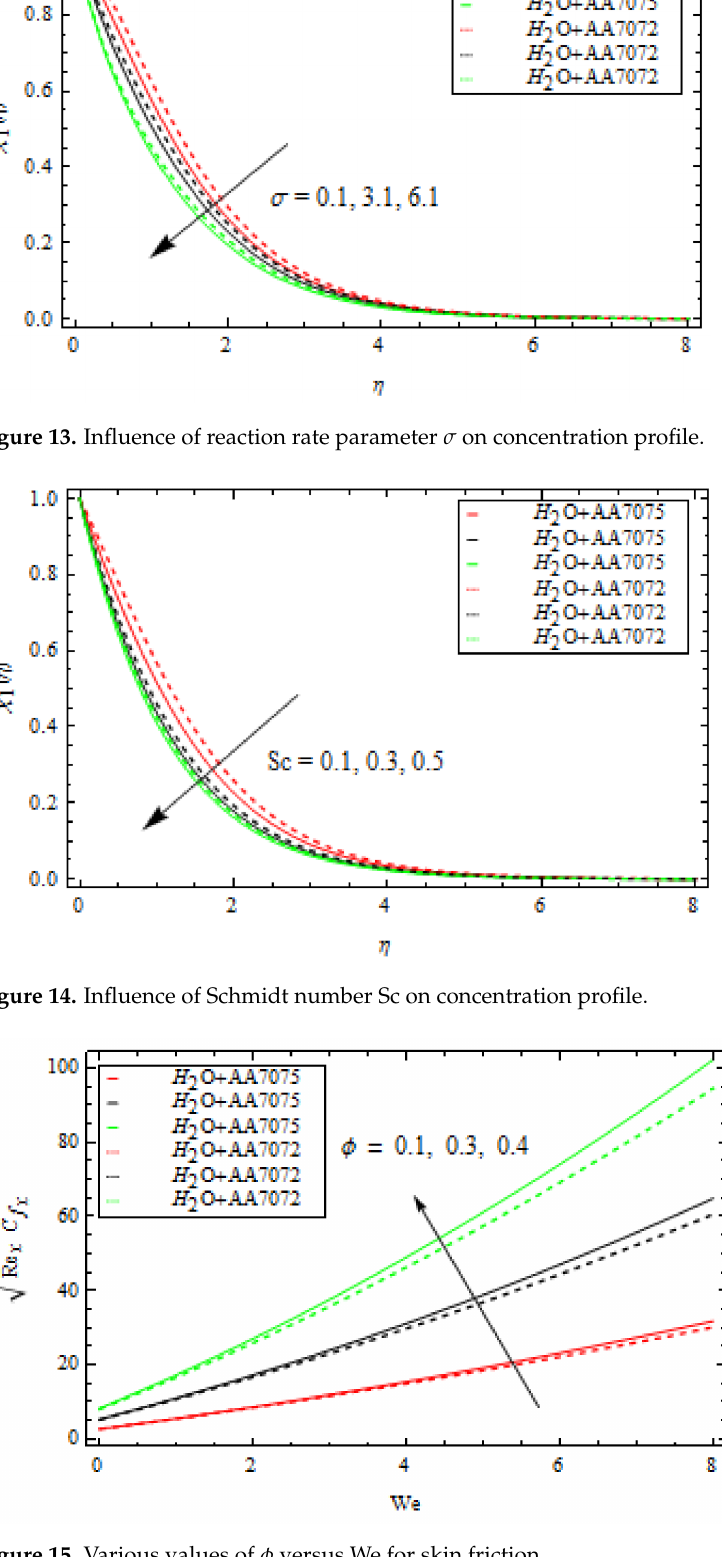
Figure 15. Various values of φ versus We for skin